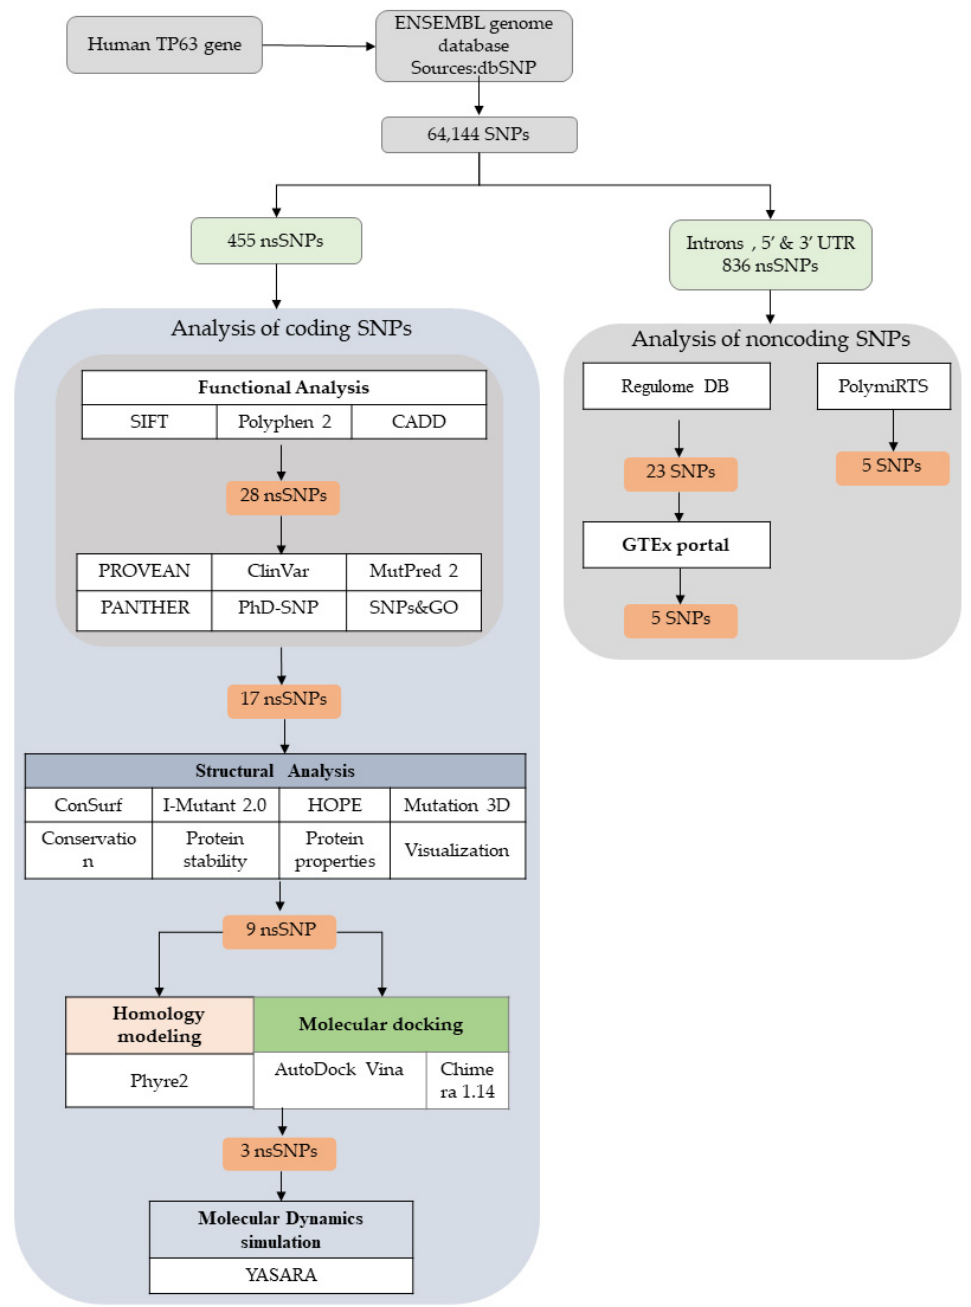
Figure 1. Schematic representation of the pipeline for in silico analysis of SNPs in the TP63 protein using different computational tools and algorithms.